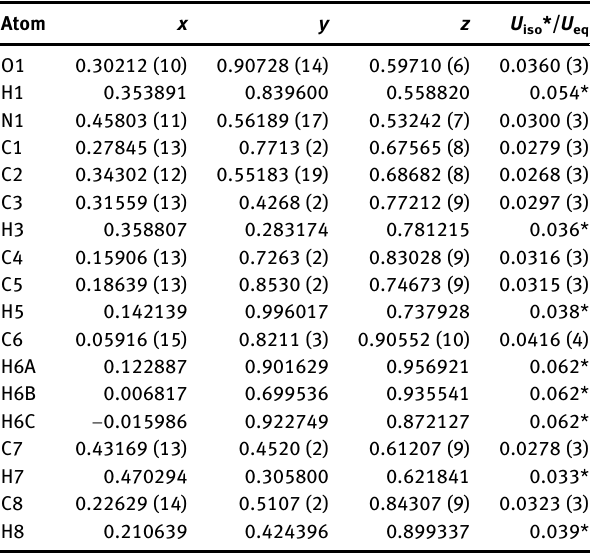
Table  : Fractional atomic coordinates and isotropic or equivalent isotropic displacement parameters (Å 